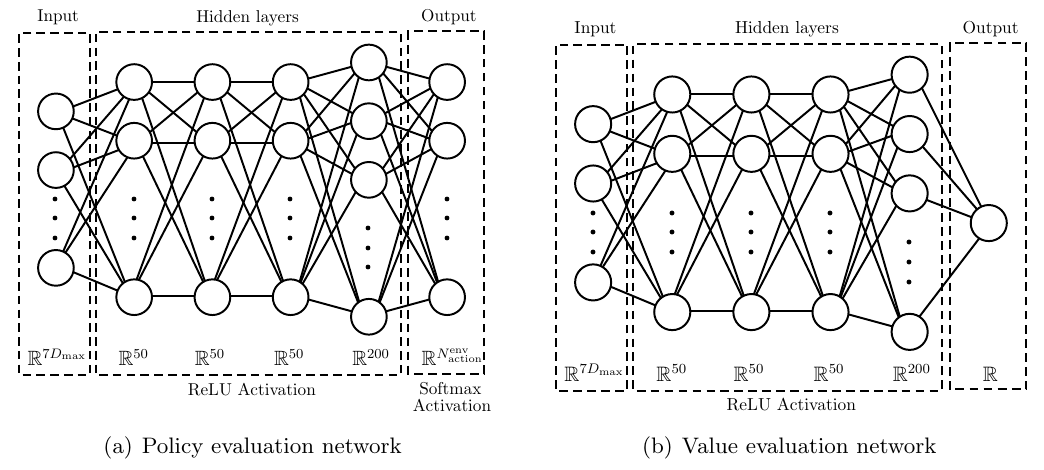
Figure 2 . The neural network architectures used for policy and value